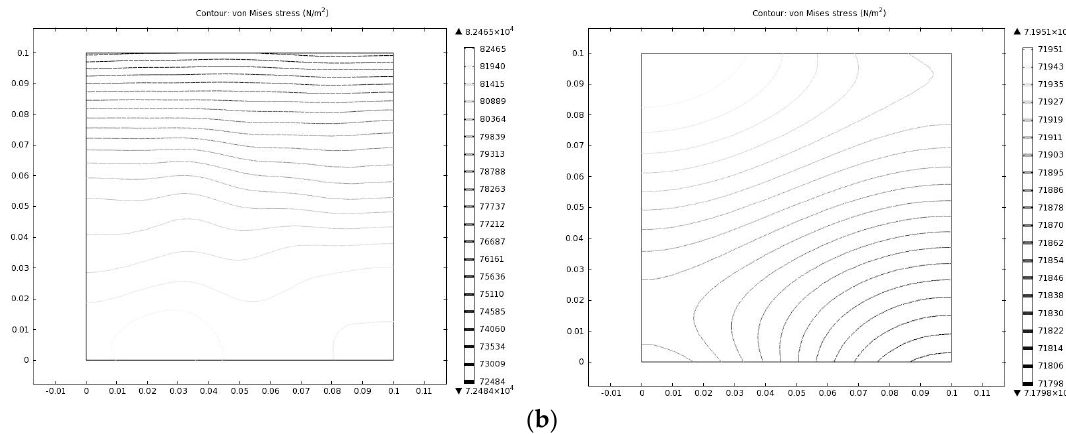
Figure 7. Phase dynamics outside inflection point interval: ( a ) phase distribution at different time instant for states outside the inflection point interval; and ( b ) von mises stress at different time instant for states outside the inflection point interval.